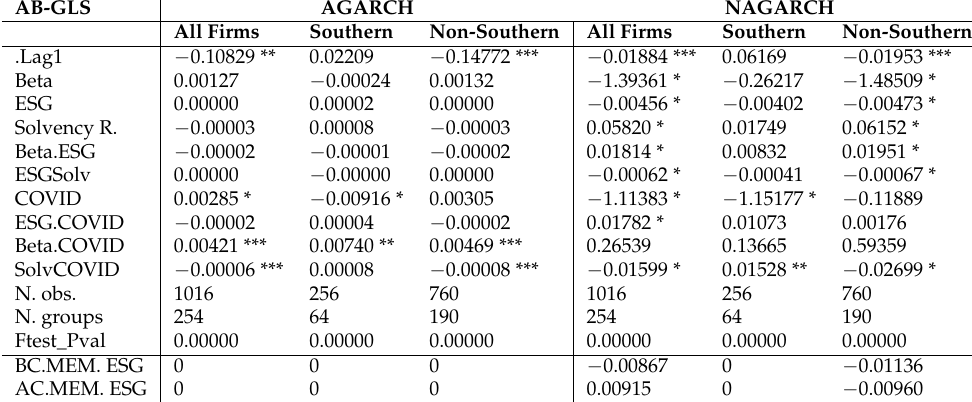
Table 5. AB-GLS estimation results for all models, Part I.